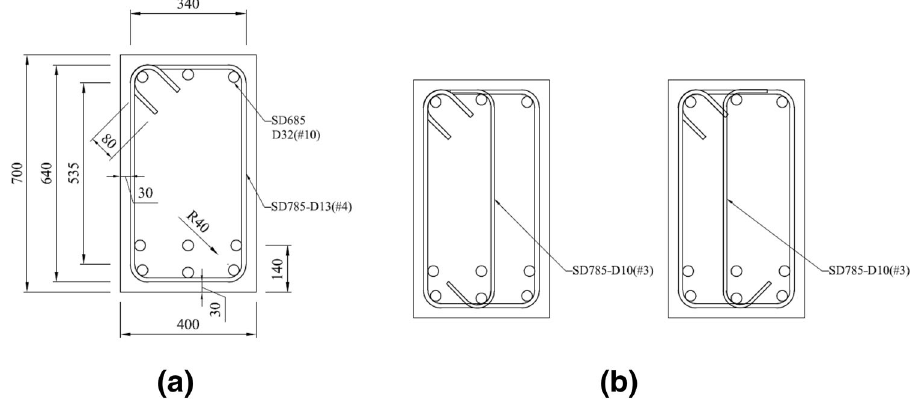
Fig. 8 Detailed reinforcement arrangement of the specimen sections. a 3C15S and b 3C20T.